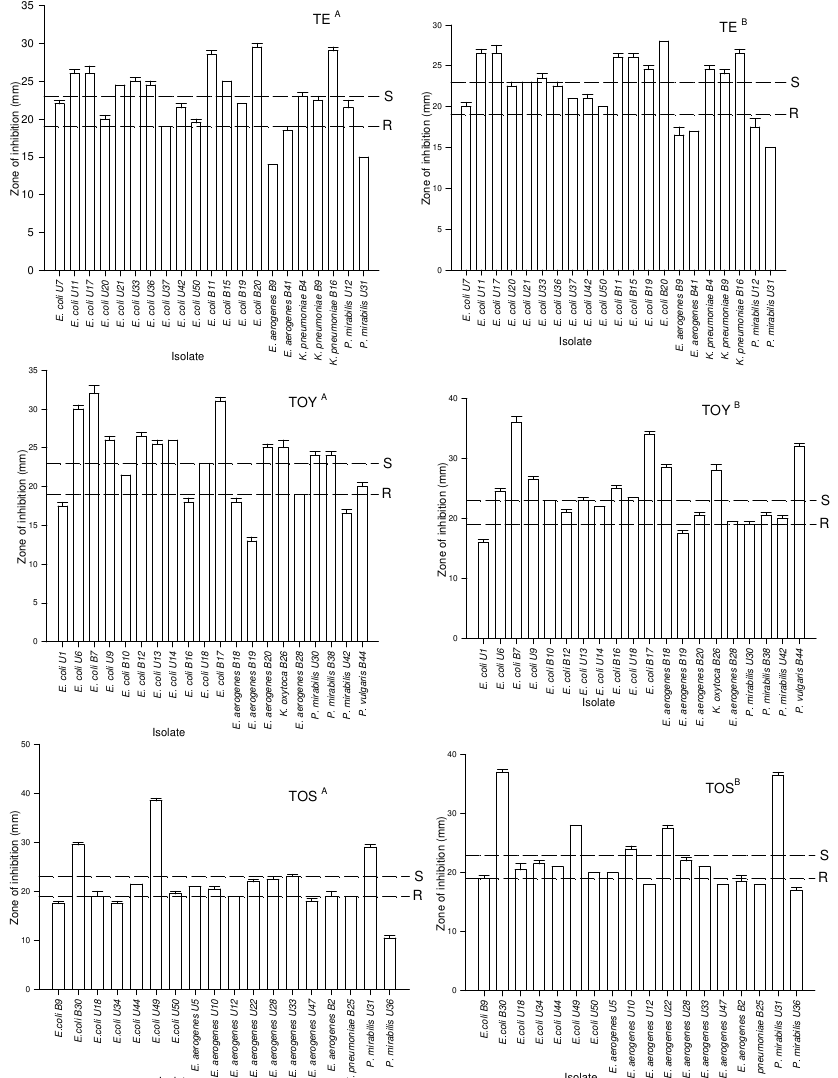
Fig. 3. Susceptibility of the isolates to meropenem and imipenem; A represents meropenem; B represents